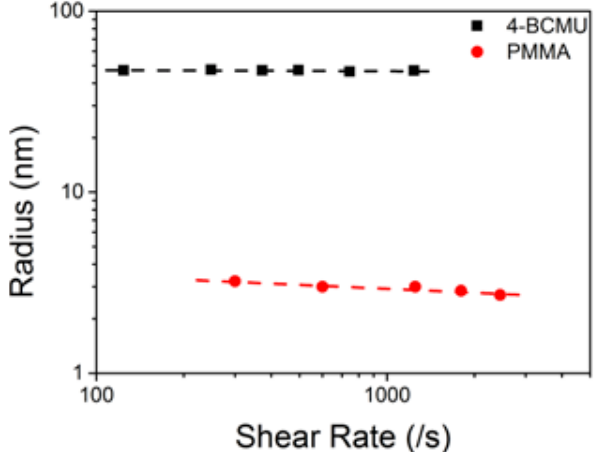
Figure 1. Measured end-to-end distance plotted as log r versus log shear rate. ata for 800kD 4-BCMU. 18 has the fitted equation: log ( r ) γ∙ = – 0.0046 log ( ) + 1.7 with the coefficient of determination: R 2 = 0.23. Data for 49kD FRET tagged PMMA in Couette flow 22 shows ∙ the fitted equation: log ( r ) = – 0.0072 log ( γ ) + 0.69 with R 2 = 0.88. The lines of best fit yield an inverse 0.07±0.02 power of the radius with shear rate for the PMMA and 0.0042±0.002 for the 4-BCMU. The error bars are approximately the size of the symbols. The error associated with each point is: ~5% in the shear rate due to the radi- us/gap ratio of the Couette cell. For the 4-BCMU the un-sheared size of the chain is 49±1nm and for PMMA the size is